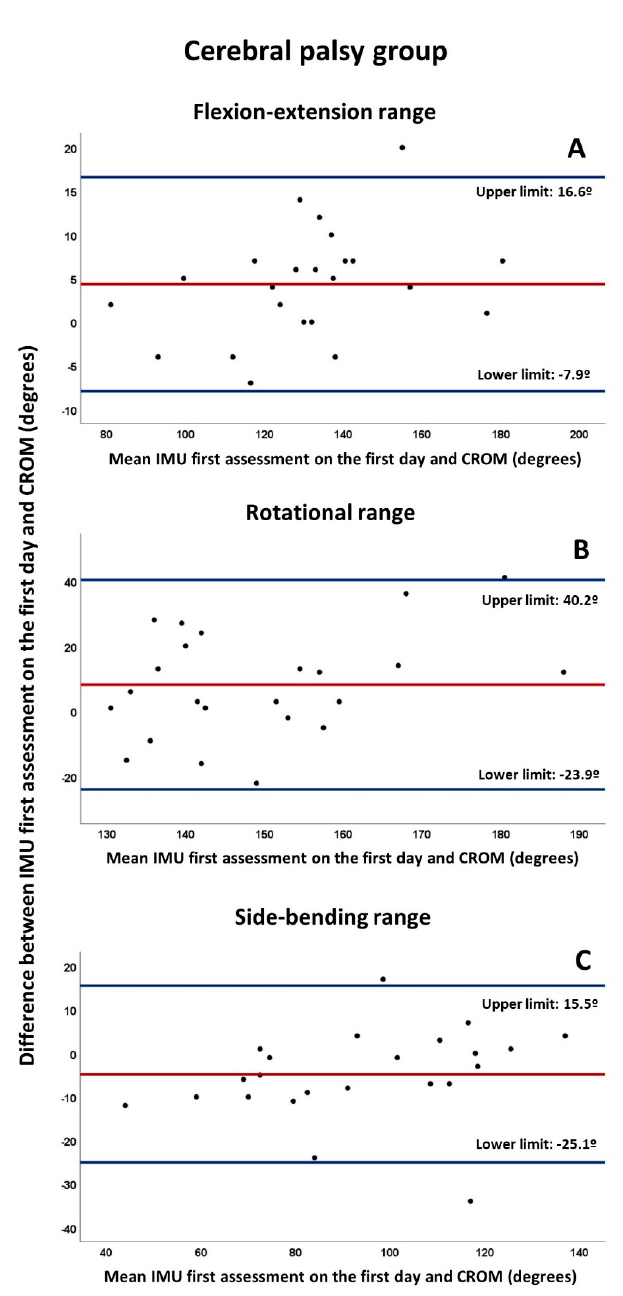
Figure 2. Bland–Altman plots for craniocervical ranges of CP group measured by IMU first assessment on the first day and the CROM in ( A ) flexion-extension range, ( B ) rotational range, ( C ) side-bending range. The red line indicates the mean bias, whereas the blue lines refers to its upper and lower limits (mean ± 1.96 standard deviation). All plots were developed as follows: the Y axis corresponds to the differences between the paired values of both methods (IMU-CROM), whereas the X axis represents the respective value of the average of both (IMU + CROM/2).